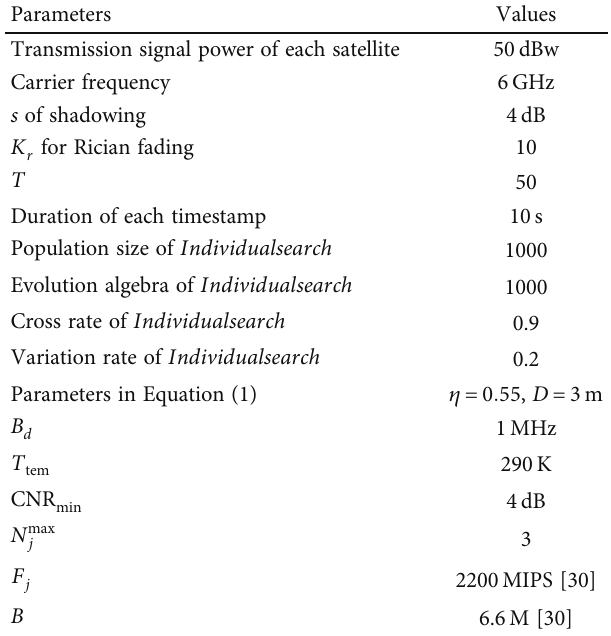
Table 4: The parameters of simulation.